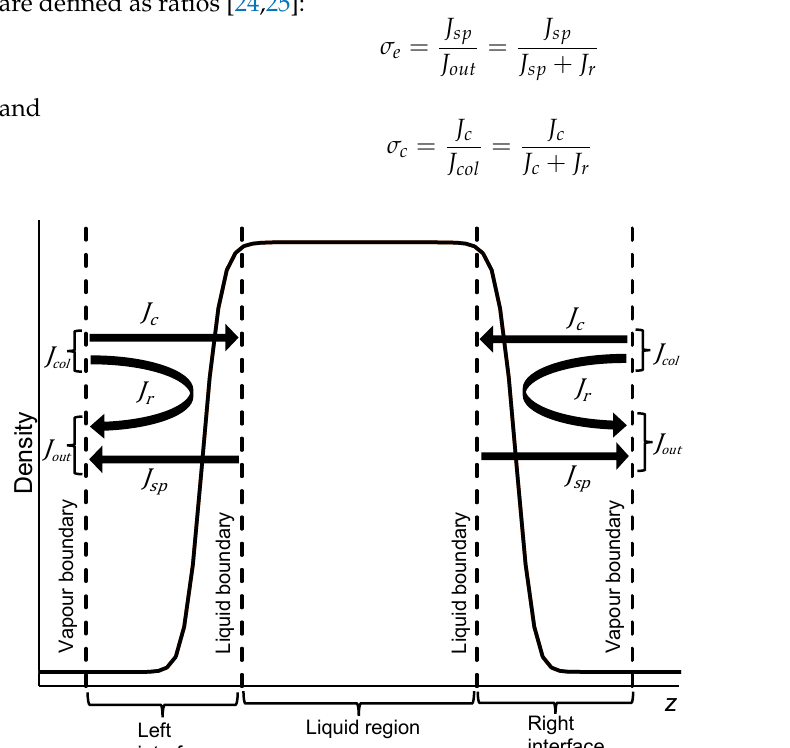
Figure 1. Phase equilibria simulation scheme with denoted interface region boundary positions and mass fluxes through the interfaces. The density profile for the scheme was obtained from the production run of the liquid-vapor phase equilibria simulation.